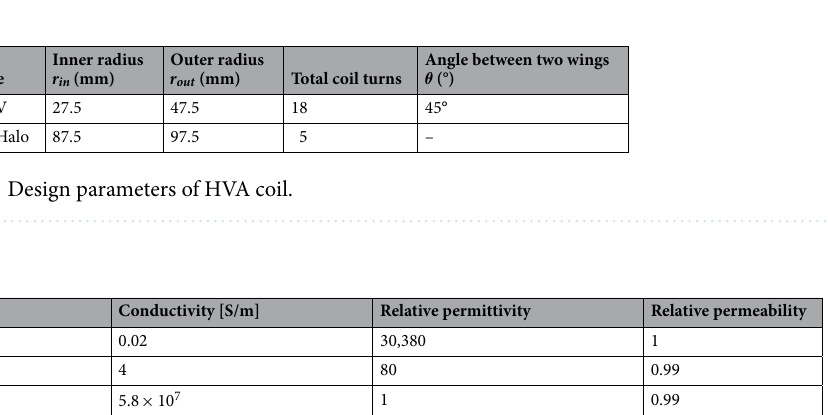
Figure 2. An illustration of HVA coil configuration with two shell human head model. The clockwise and anti- clockwise directions of coil current are indicated as red and green arrow line respectively.